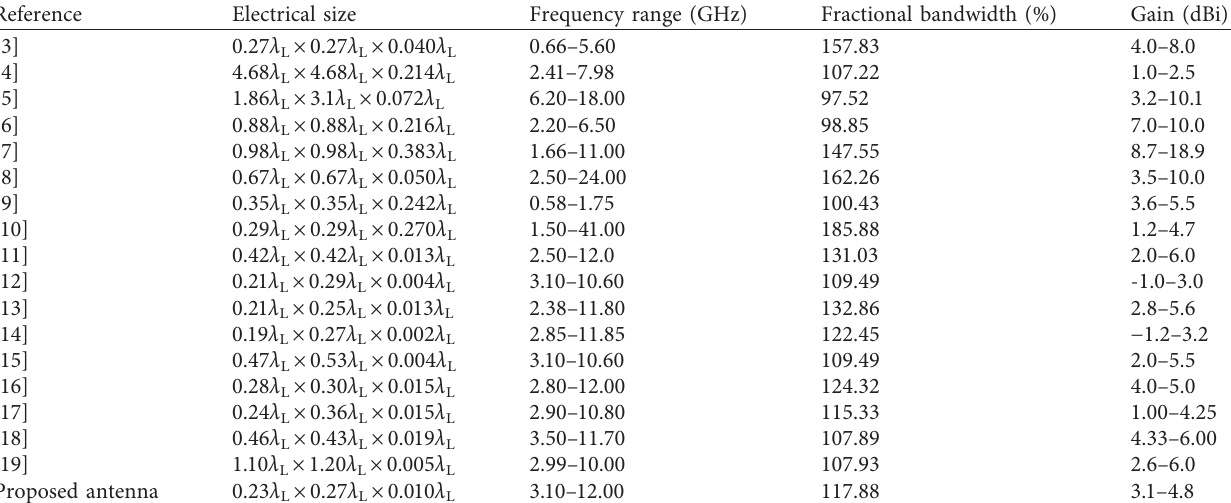
Table 3: Comparison of the performance of the proposed antenna with the current state of the art in UWB antennas. Reference